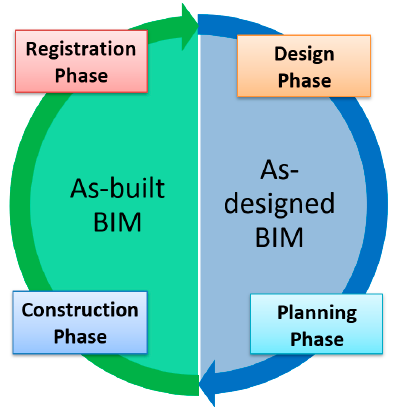
Figure 11. Proposed BIM-driven subdivision workflow.